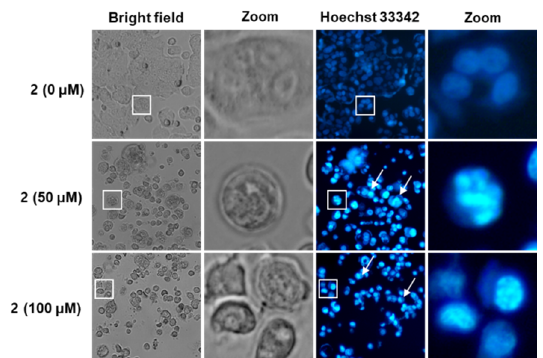
Figure 4. Effects of aviculin ( 2 ) on nuclear morphologies of MCF-7 human breast cancer cells. Representative fluorescence microscopy images of Hoechst 33342 stained cells (20× magnification). Control cells were treated with 0.5% DMSO. Several independent images were photomicrographed and representative images for each condition are shown. Condensed and bright nuclei (white arrow) in the enlarged image marked in white square are indicative of apoptotic cell death.